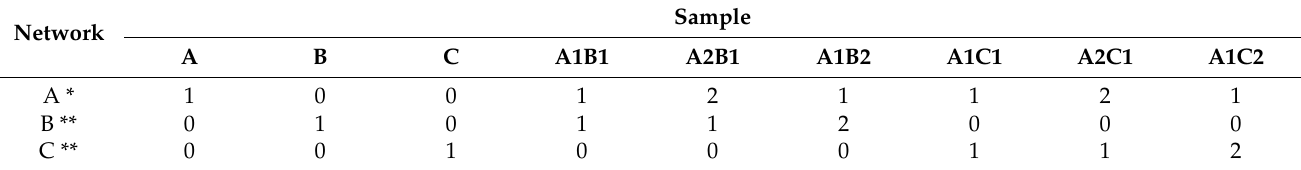
Table 1. The wt % ratios used to obtain the reference samples and the IPNs (AxBy or AxCy). Network